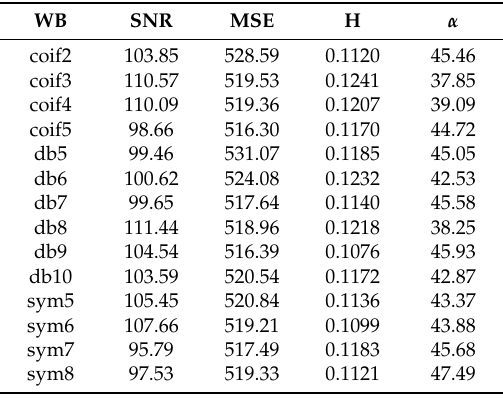
Table 2. Denoising effects evaluated with different